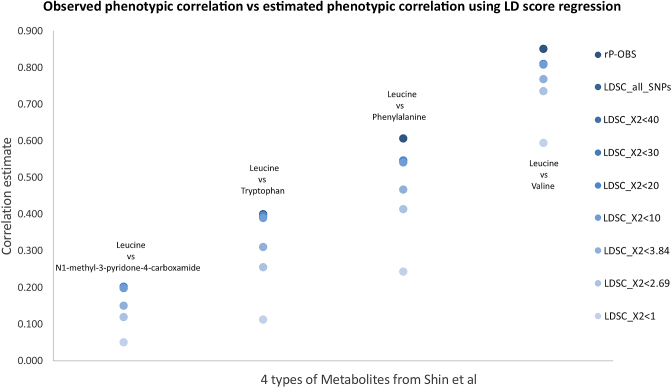
Validation of the influence of number of causal variants on phenotypic correlation estimation. Four pairs of metabolites (leucine against N1-methyl-3-pyridone-4-carboxamide, tryptophan, phenylalanine, and valine) from Shin et al. [13] were selected based on their observed phenotypic correlations (0.2, 0.4, 0.6, and 0.85, respectively). Eight sets of SNPs were selected to estimate the phenotypic correlations using LD score regression. The 8 sets were all GWAS SNPs; SNPs with Chi square statistics (square of Z scores) smaller than 40; SNPs with X2 < 30; SNPs with X2 < 20; SNPs with X2 < 10; SNPs with X2 < 3.84; SNPs with X2 < 2.69; and SNPs with X2 <1. Notes: Four columns on the x-axis were the four selected pairs of metabolites. The y-axis was the value of the phenotypic correlation. Dark blue points are the observed phenotypic correlations (noted as rP-OBS). The lighter blue points are the eight groups of SNPs included in the phenotypic correlation estimation using LD score regression (noted as LDSC_X2).